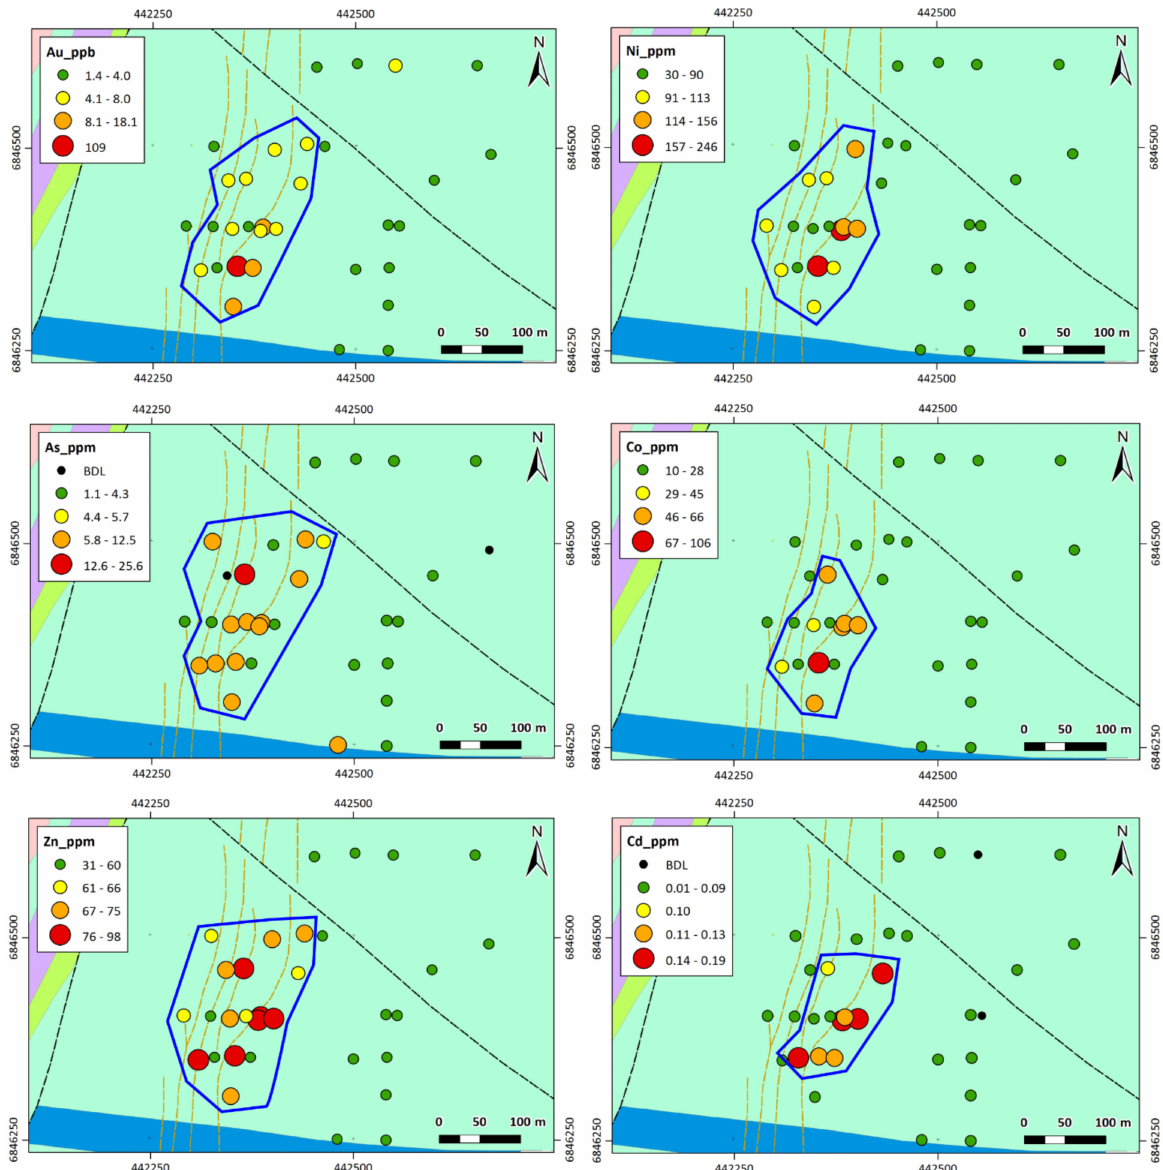
Figure 17. Bubble plot of interface samples collected from 32 RC drill holes (Figure 2) showing elevated contents of Au, As, Ni, Co, Zn, and Cd over the mineralization compared to the background. The anomaly appears to be the smallest for Co, and Cd and the largest for Au, Ni, As, and